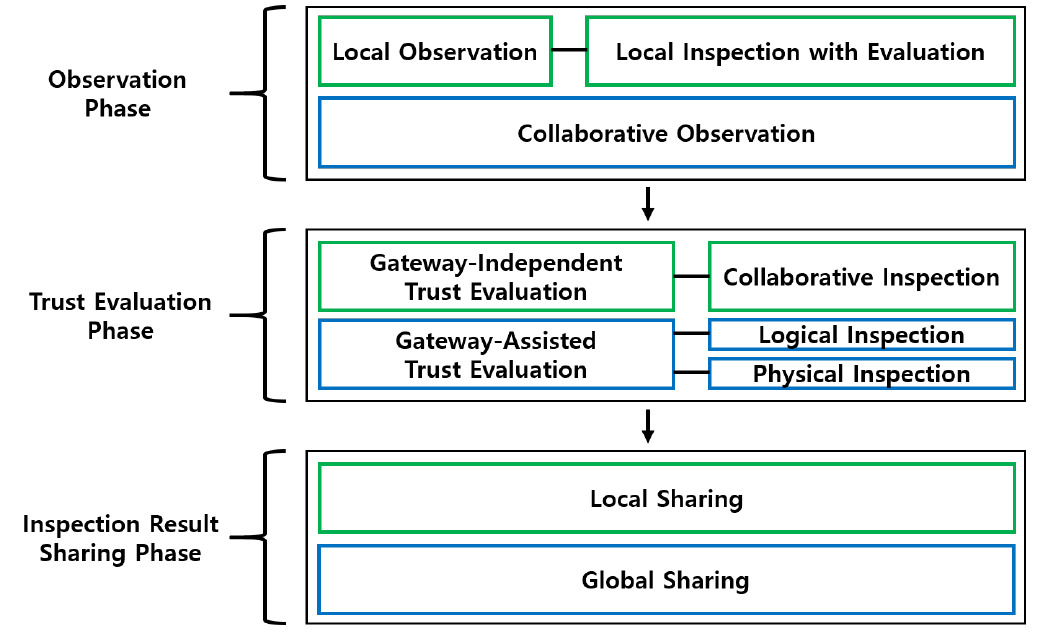
Figure 2. Overall structure of the proposed